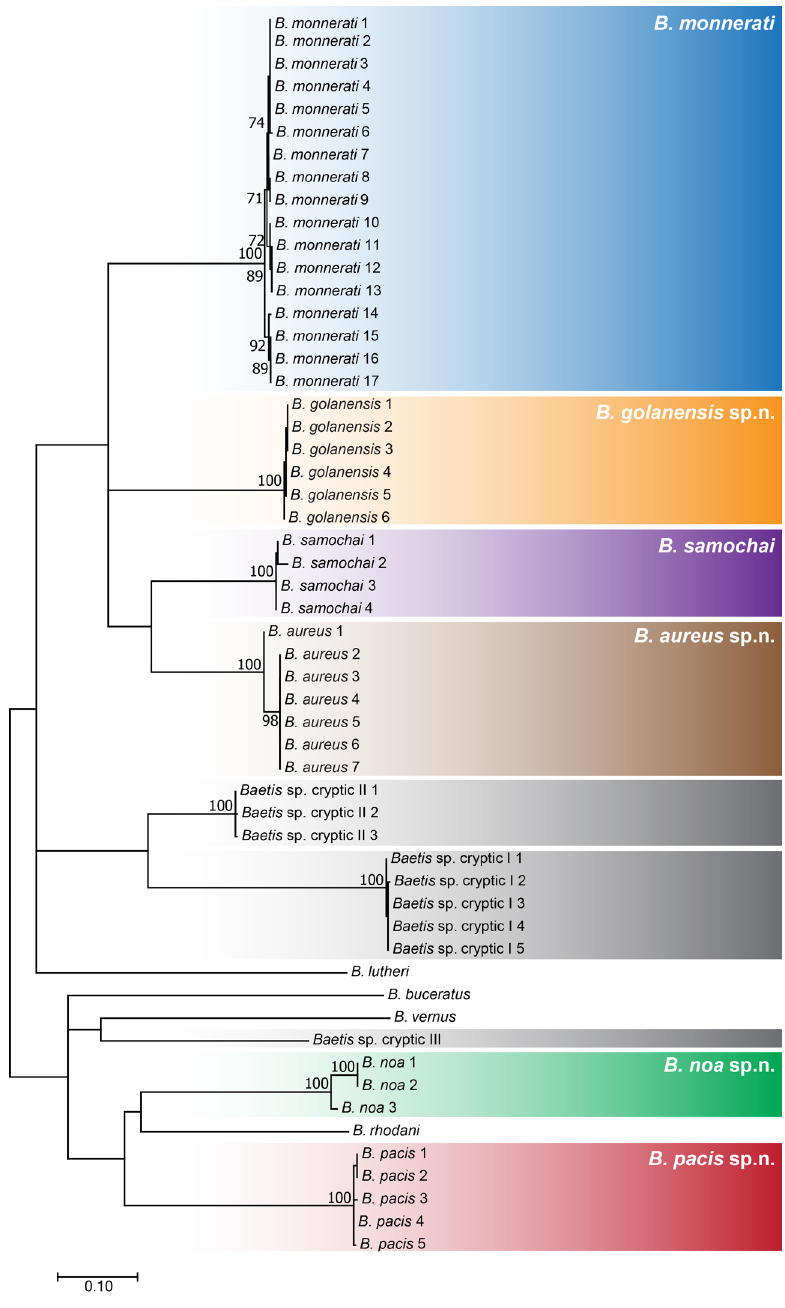
Figure 3. A Maximum Likelihood phylogenetic reconstruction based on sequences of the mitochondrial COI gene obtained from Israeli and related species. The validity of six Israeli species is confirmed and strongly supported. Gray shaded clades represent cryptic species that are morphologically indistinguish- able from the species described here. Bootstrap values above 70% are indicated next to the